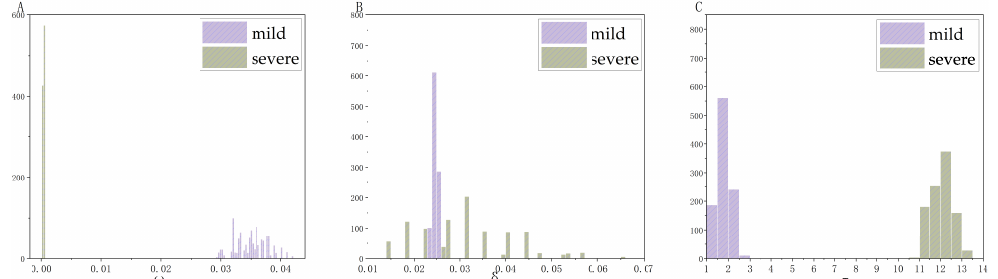
Figure 8. Bootstrap sampling distribution of Model 2 parameters: ( A ) ω ; ( B ) δ T ; ( C ) τ ; The kurtosis of ω , δ T , τ of severe patients is − 0.61, − 0.42, and − 0.41; the kurtosis of mild patients is − 0.29, 0.062, and 10.95. The distribution of each parameter was found to be significantly different between patients with mild and severe disease using the Mann–Whitney test ( p -value <